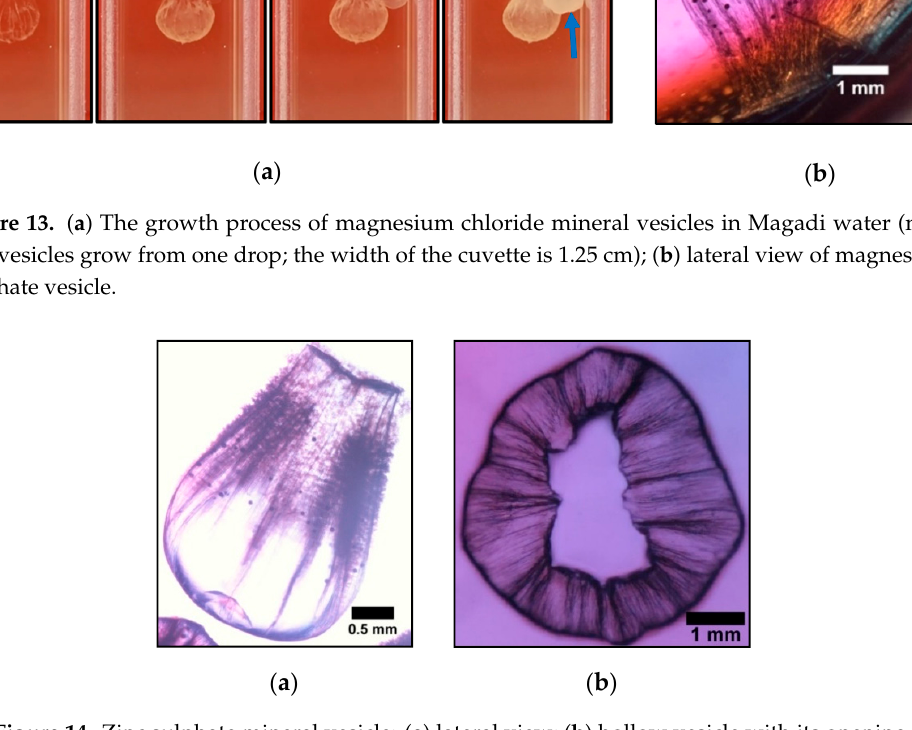
Figure 13. ( a ) The growth process of magnesium chloride mineral vesicles in Magadi water (note: two vesicles grow from one drop; the width of the cuvette is 1.25 cm); ( b ) lateral view of magnesium sulphate vesicle.